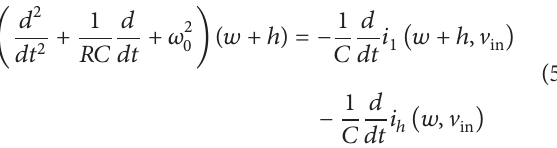
Figure5:Circuitdiagramofadivide-by-three 𝐿𝐶 -CMOSfrequency divider with a direct forcing